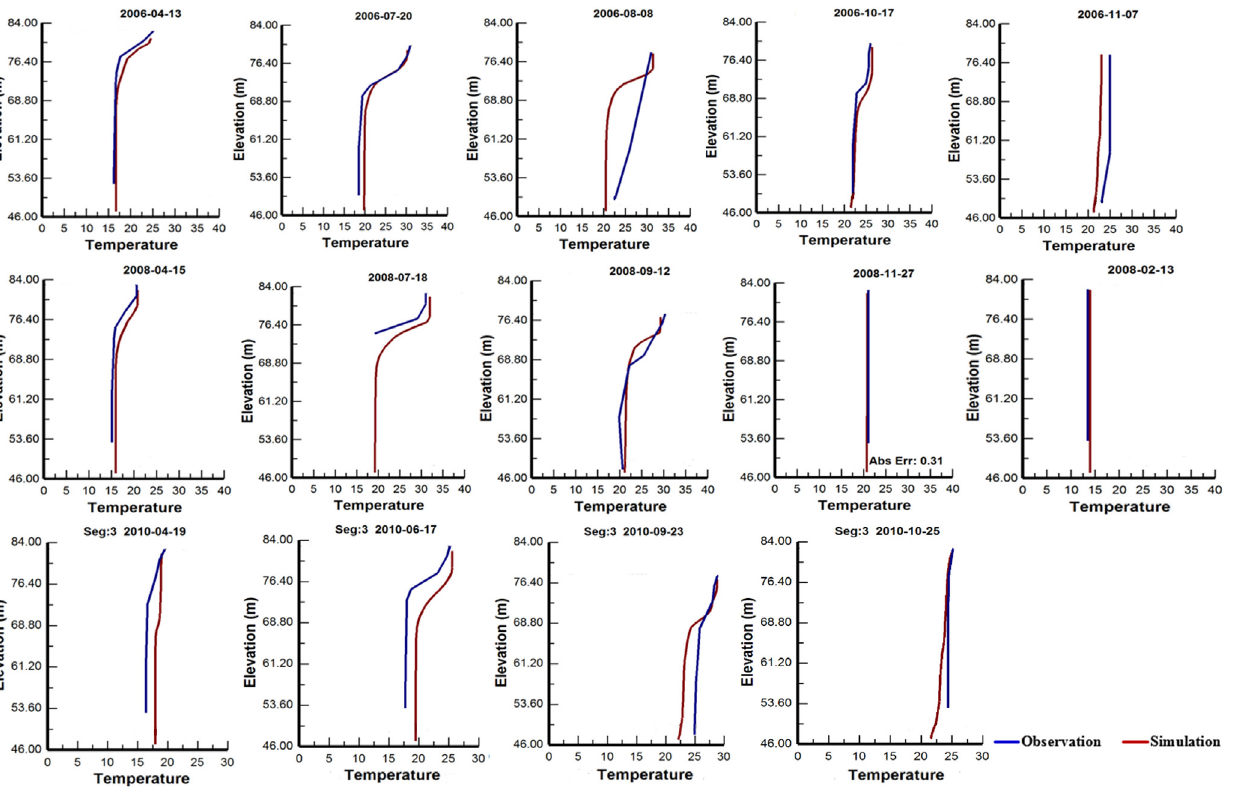
Figure 5. Comparisons between W2 simulated and observed water temperature profiles (°C) in